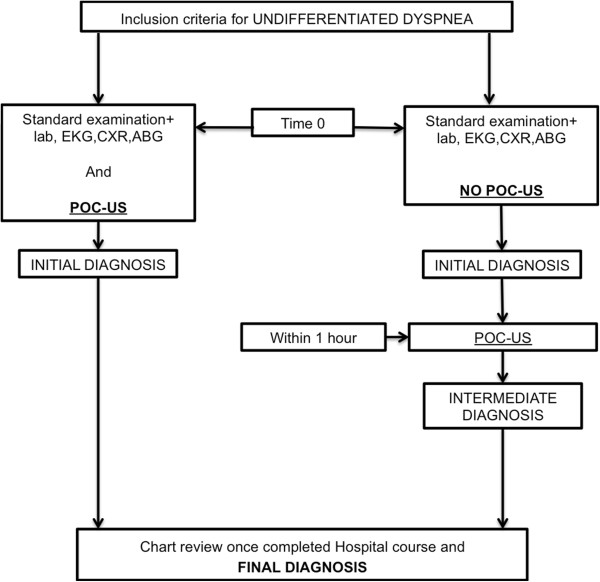
Study design. ECG, electrocardiogram; CXR, chest radiograph; ABG, arterial blood gases.